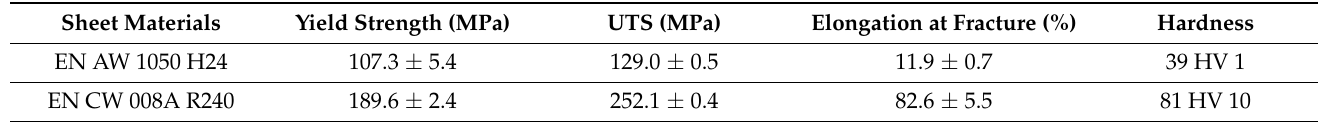
Table 1. Selected mechanical properties of the base materials. Sheet Materials Yield Strength (MPa) UTS (MPa) Elongation at Fracture (%) Hardness EN AW 1050